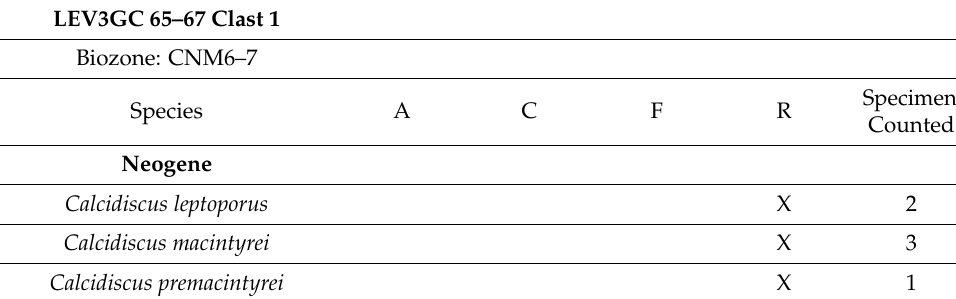
Table A15. Heraklion